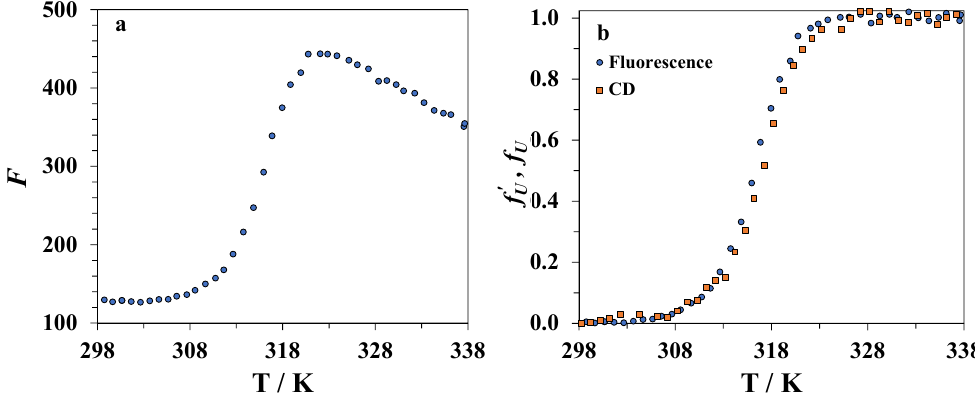
Figure 5. ( a ) Changes in lysozyme fluorescence intensity with an increasing temperature in the DMSO–water mixture with a DMSO mole fraction of x 1 = 0.30. ( b ) The temperature dependence of the degree of unfolding of lysozyme as determined from the fluorescence (circles) and CD (squares) data in the DMSO–water mixture with a DMSO mole fraction of x 1 = 0.30.